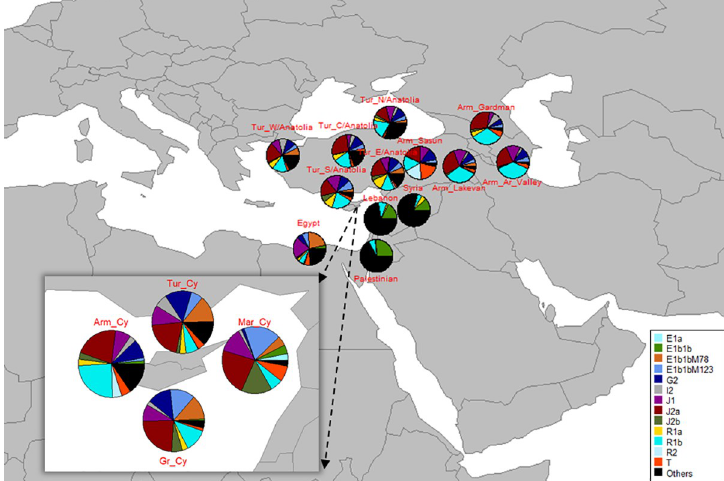
Fig 3. Y-haplogroup frequencies of all Cypriots and all specified populations in the current study. The zoom-in window shows all the Y-haplogroup frequencies among all Cypriots in pie charts. The dark red color, which corresponds to Y-haplogroup J2a, was common in all Cypriots, Armenians and Turks, while it was not observed in Palestinian, Lebanese, Egyptian and Syrian populations. Y-haplogroup R1b was observed in all populations but in different